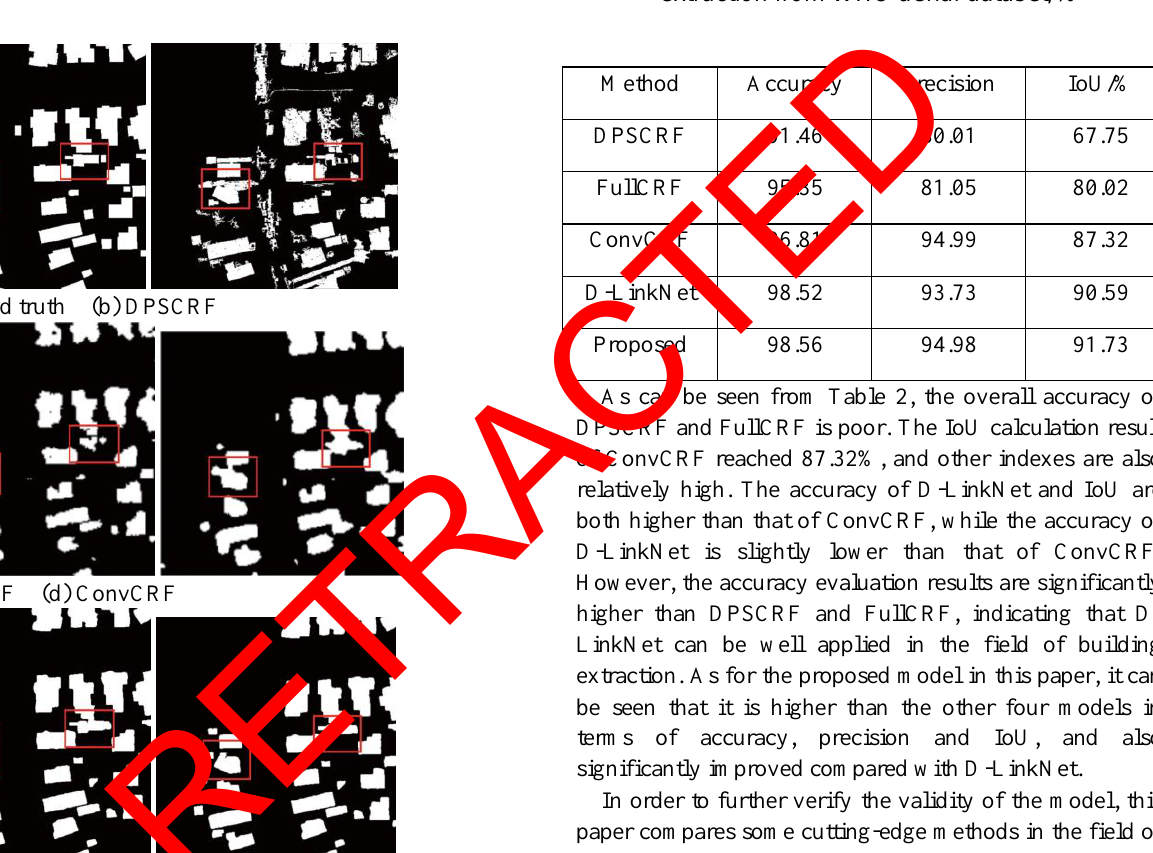
Figure 3. Original images and labels